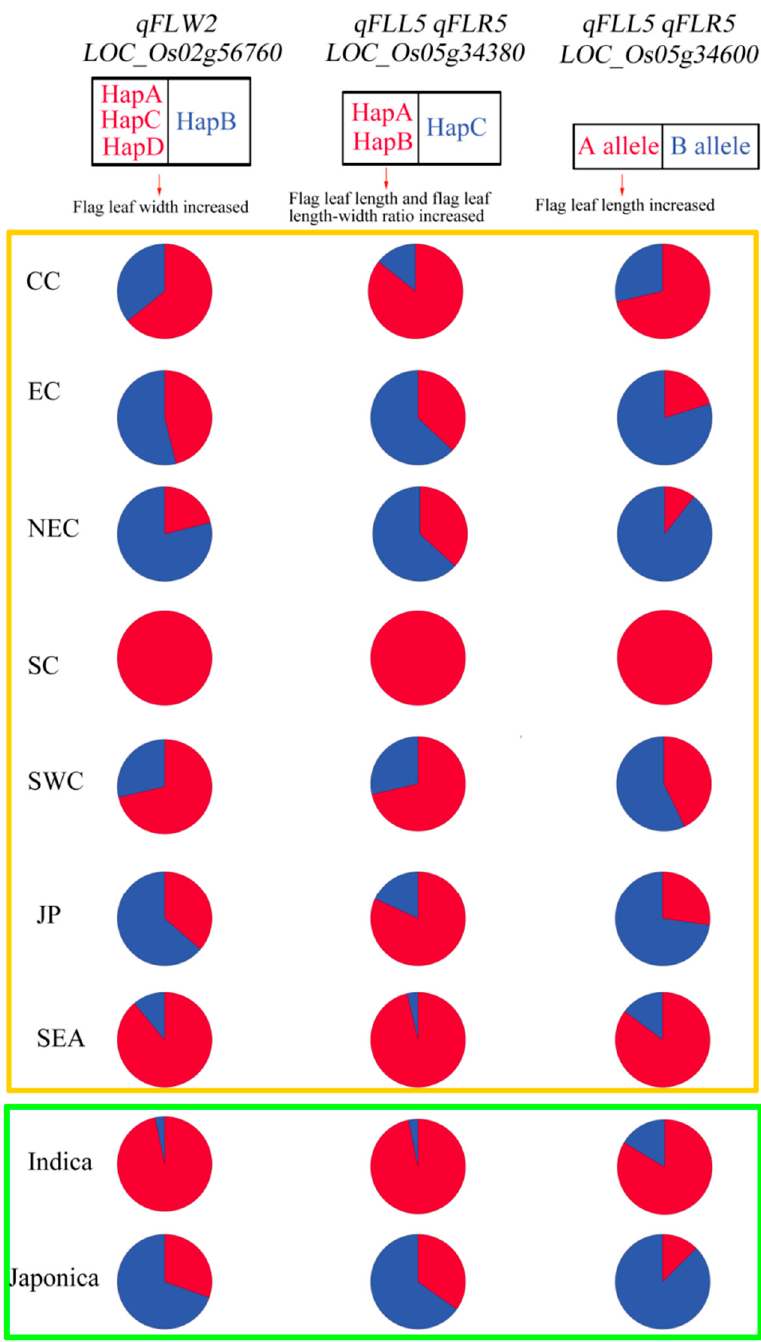
Figure 9. Haplotypes of candidate genes in seven geographic groups and two subgroups. Red repre- sents favorable haplotypes and the blue represents non-favorable haplotypes. Yellow box represents by regions and the green box represents by subgroups. SC, southern China; CC, central China; EC, eastern China; NEC, northeastern China; SWC, southwest China; JP, Japan; SEA, southeast